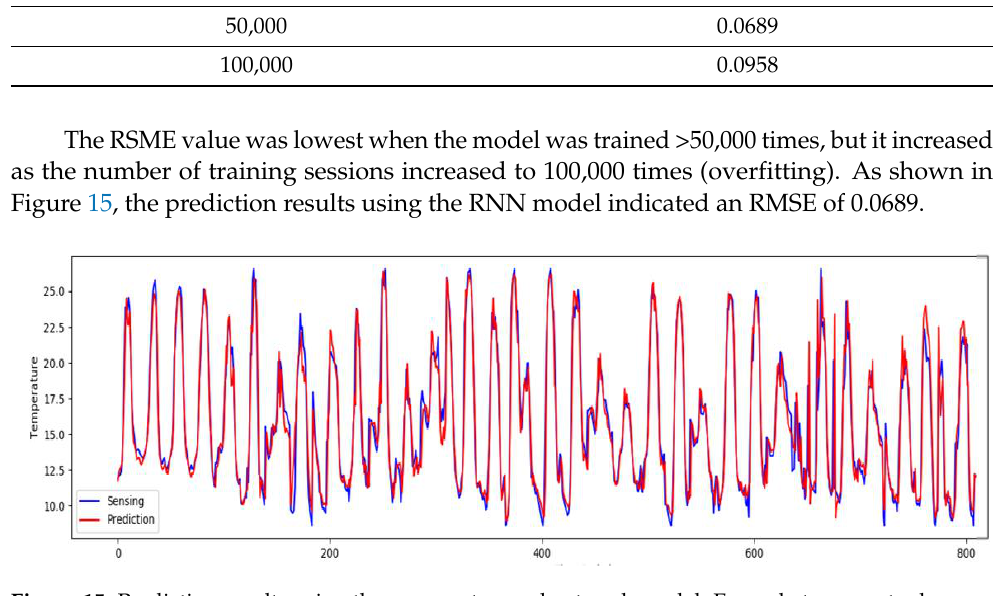
Figure 15. Prediction results using the recurrent neural network model. Errors between actual sen- sor data (blue lines) and predicted values (red lines) are shown. data (blue lines) and predicted values (red lines) are